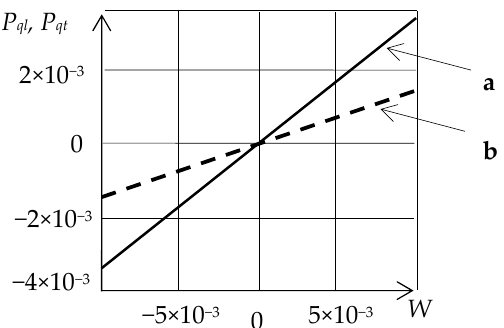
Figure 2. The dependence of the ratio of the ellipse polarization axes for quasi-longitudinal ( a ) and quasi-transverse ( b ) waves on the relative angular velocity.